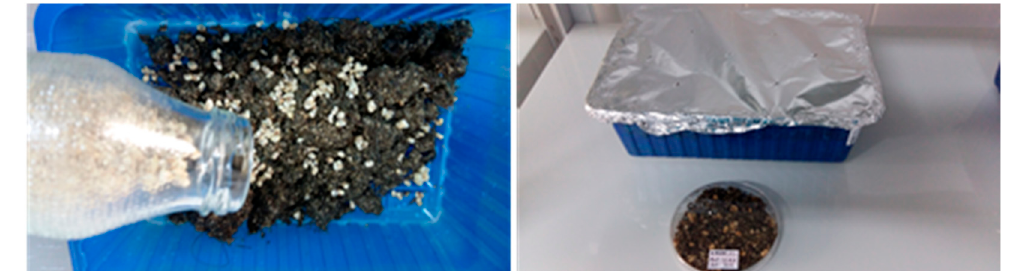
Figure B1. Compost sowing with Agaricus Blazei Murrill mushroom mycelium: ( left ) compost sowing; ( right ) sow tray covered with aluminum foil. Source: Photo original—SC CIUPERC Ă RIA SRL, Aghiresu-Fabrici, Cluj County.